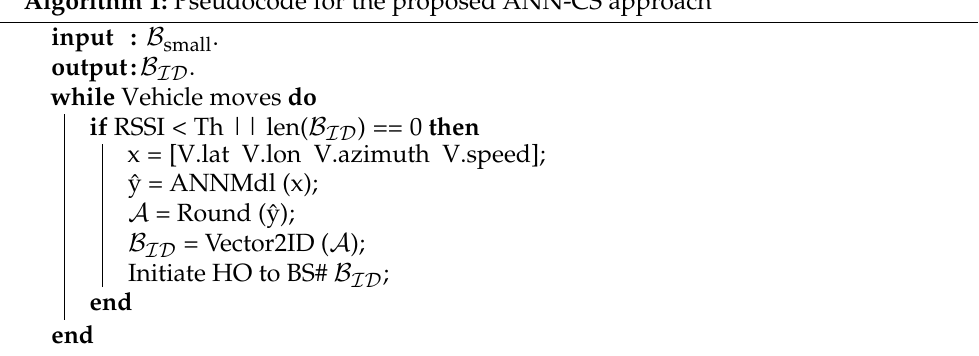
Algorithm 1: Pseudocode for the proposed ANN-CS approach